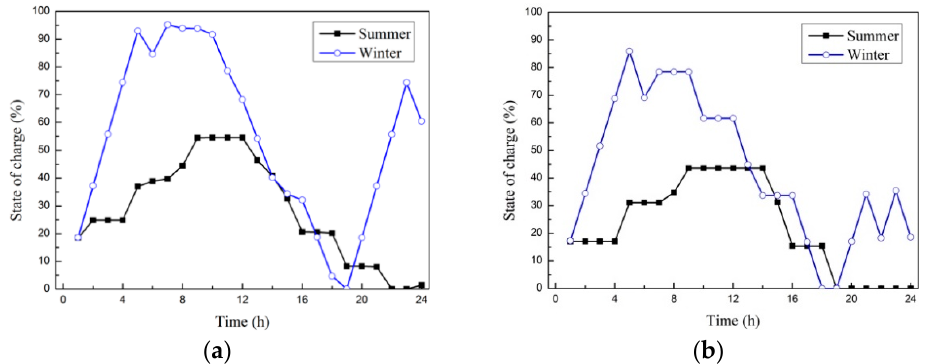
Figure 10. Comparison of SOCs between the cases with and without off-design effects consideration: ( a ) without considering off-design characteristics; ( b ) considering off-design characteristics.